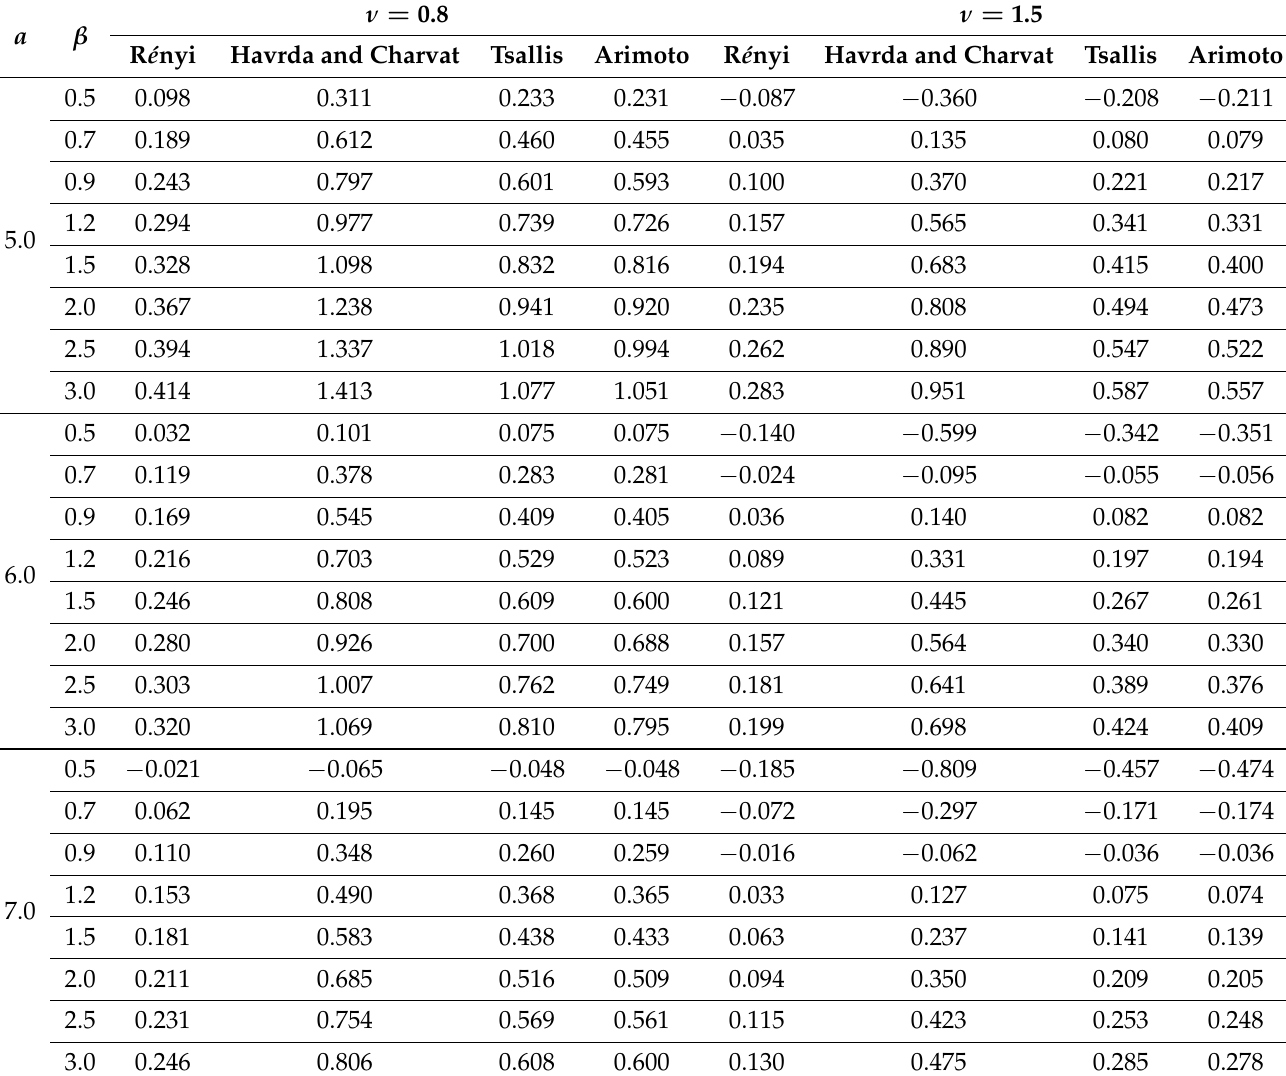
Table 2. Some numerical values of entropy at ν = 0.8,1.5.